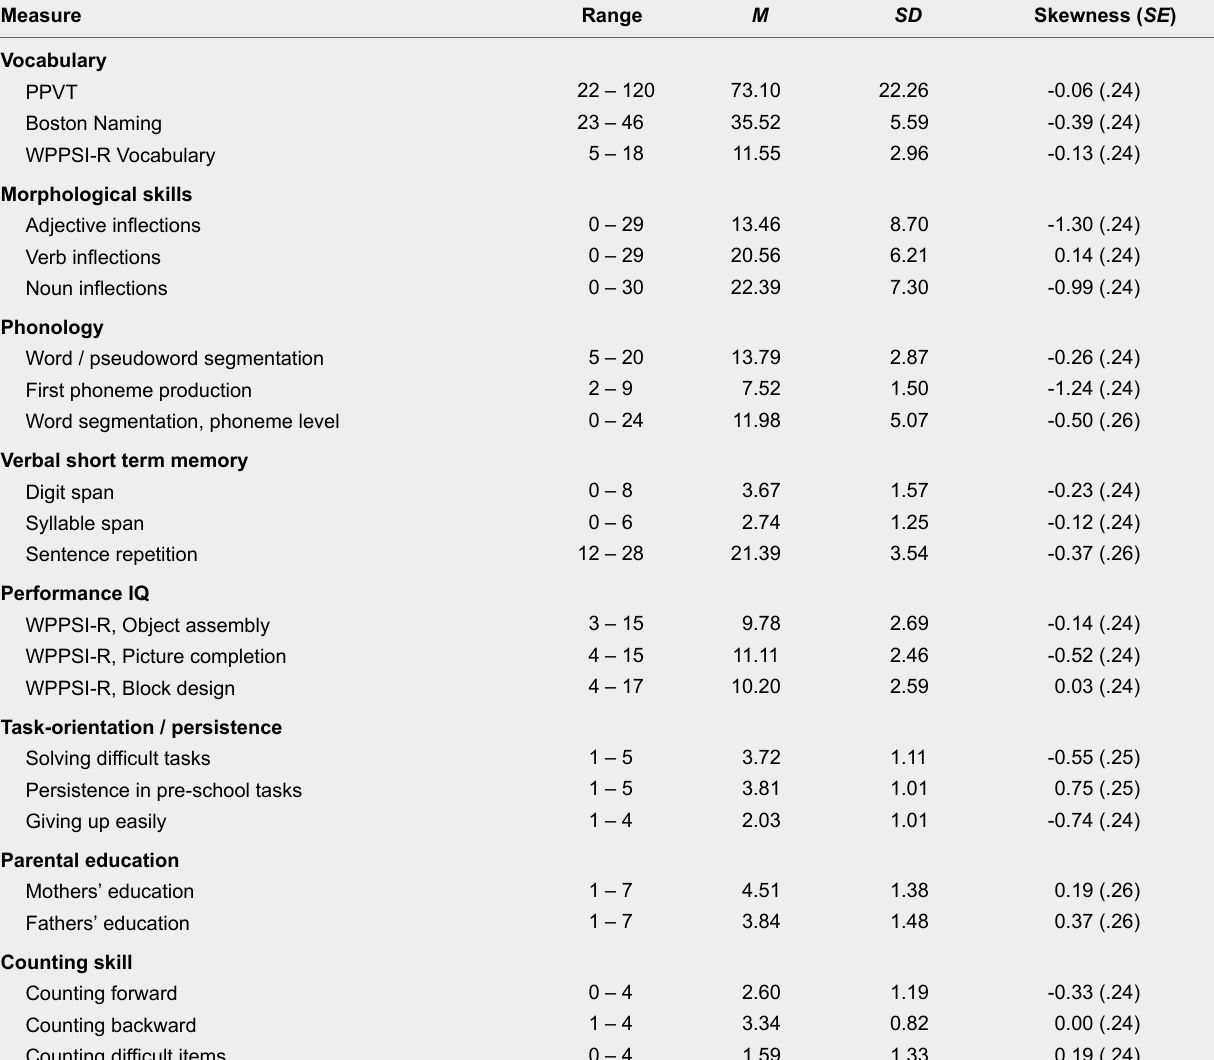
Descriptive Statistics for All Measures (Raw Scores) Used in Creating the Latent Factors Used in the SEM